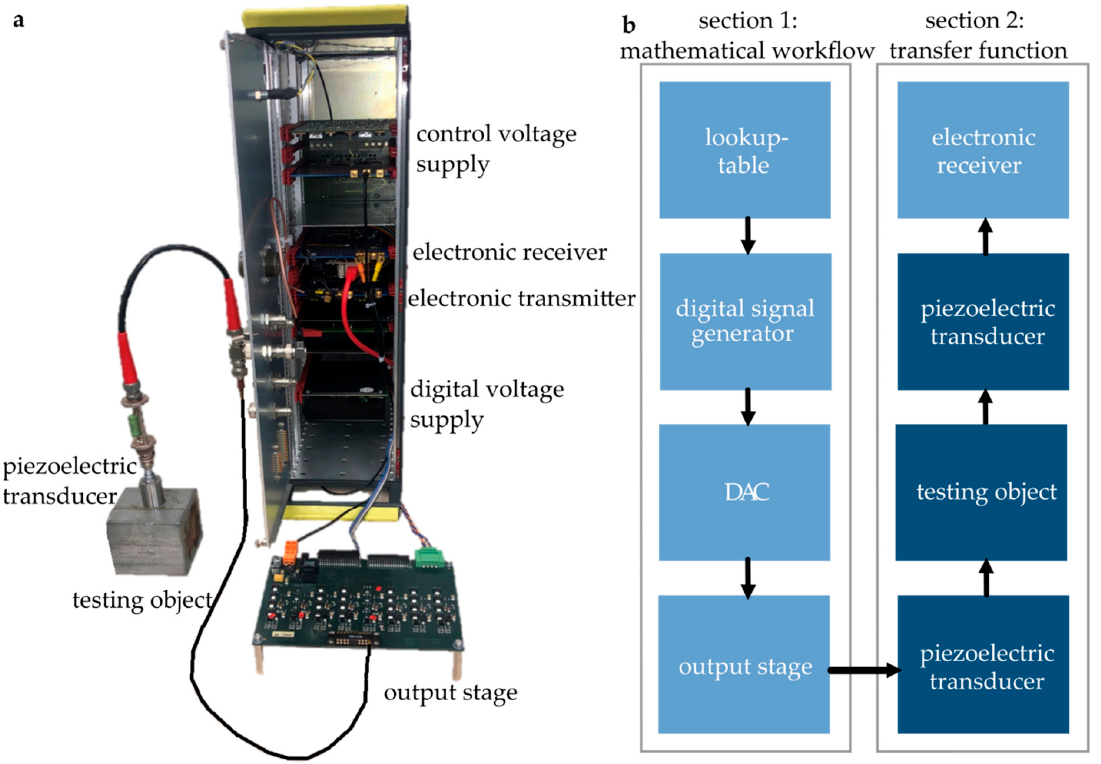
Figure 1. Experimental setup and flow diagram of the different components. ( a ) Testing system for experimental investigation of coded excitation signals; ( b ) separation of the testing system into several components for modelling: several elements were explicitly implemented in simulation (Section 1) while the second part of the workflow was included in simulation through a transfer function (Section 2).